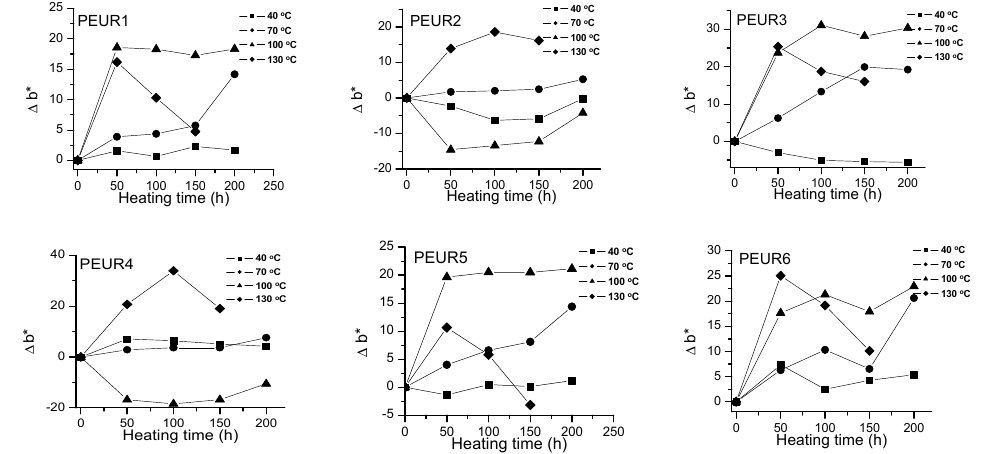
Figure 4. Variation of Δ b * with temperature and heating time of PEURs. Figure 5 shows the Δ E variation with temperature and heating time of the studied samples. The PEURs resisted up to 150 h thermal aging time, after which they became sticky or completely degraded, making color determinations difficult.